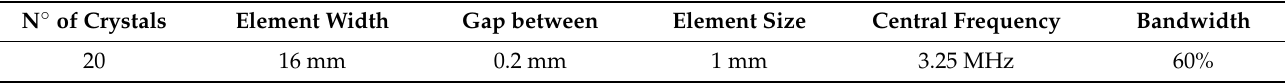
Table 3. Selected Phased array probe specifications.